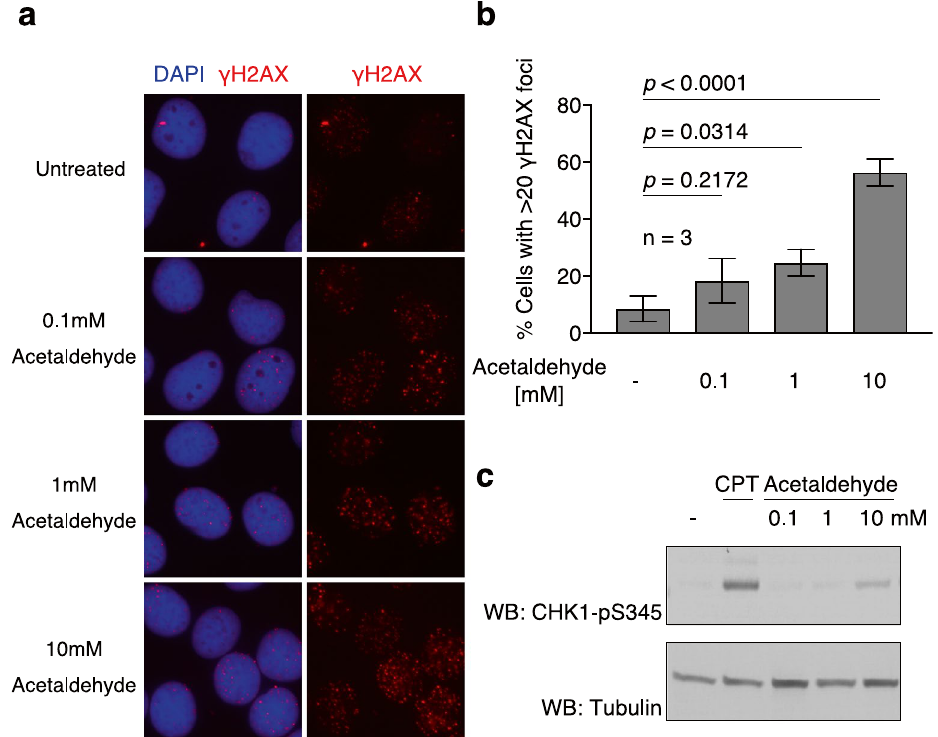
Figure 1. Exposure to acetaldehyde activates DNA damage response pathway. ( a ) Representative images of γH2AX foci without (untreated) or with the indicated concentrations of acetaldehyde in U2OS cells. ( b ) Frequency of γH2AX-positive cells untreated (−) or treated with the indicated concentrations of acetaldehyde. More than 100 cells were counted at each concentration. Statistical significance was determined using an unpaired t test. Error bars indicate standard deviation (n = 3). ( c ) CHK1-pS345 Western blot of whole cell extracts from HCT116 cells treated with the indicated concentrations of acetaldehyde or 100 nM camptothecin (CPT). Tubulin western blotting was used as a loading